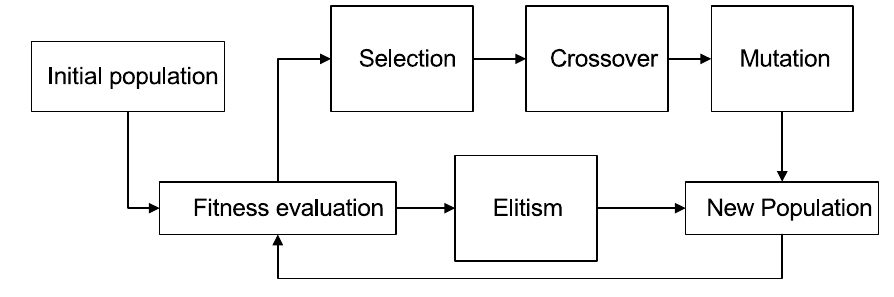
Figure 3. Main steps of genetic algorithm (GA).